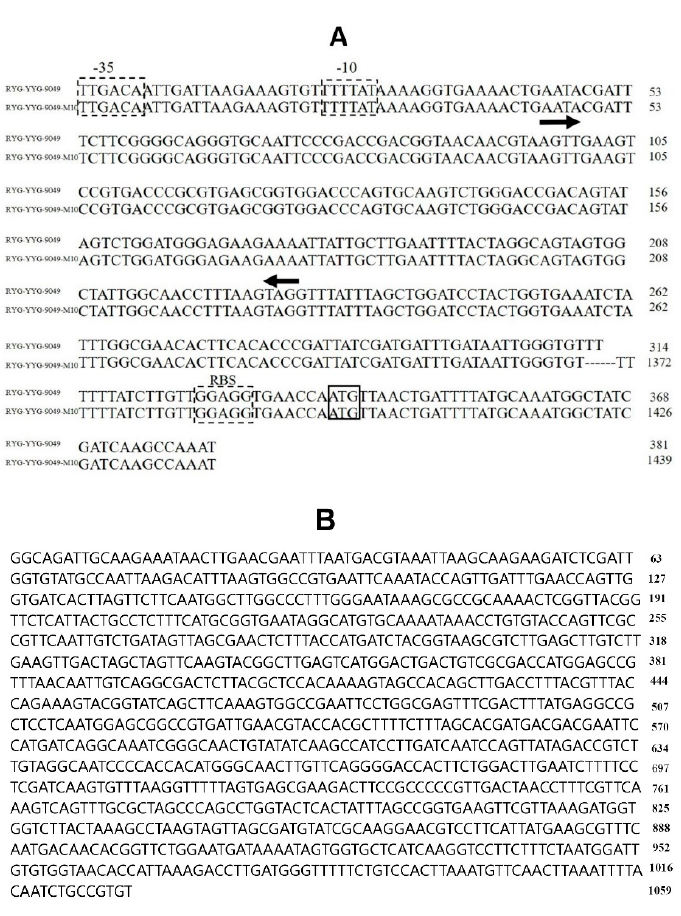
Figure 4. ( A ) Alignment of the rib operon regulatory region of RYG-YYG-9049 and its mutant strain. The predicted − 10 and − 35 recognition sequences and ribosomal binding sites (RBS) are boxed. The ellipsis represents the increased gene sequence of the mutant strain. The ribG start codon is boxed with solid lines. The RFN element is indicated by the arrows below. ( B ) The inserted 1059-bp gene sequence.